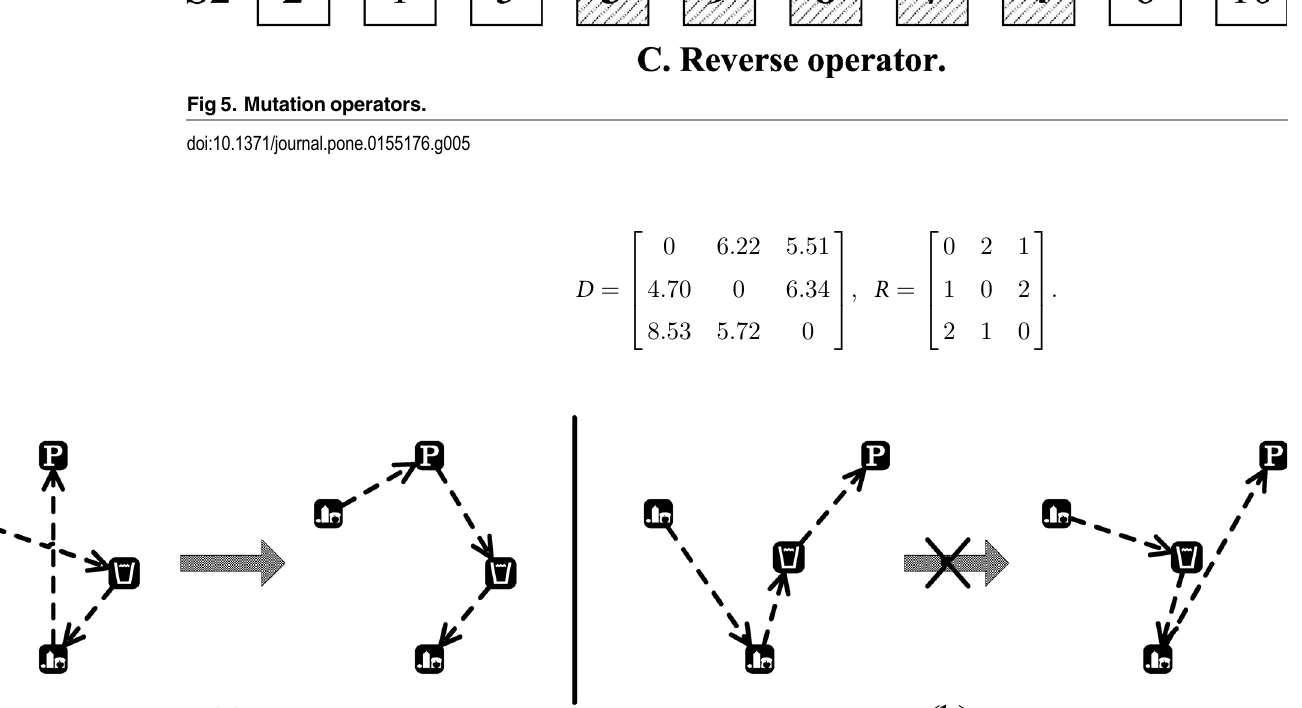
Fig 5. Mutation operators.